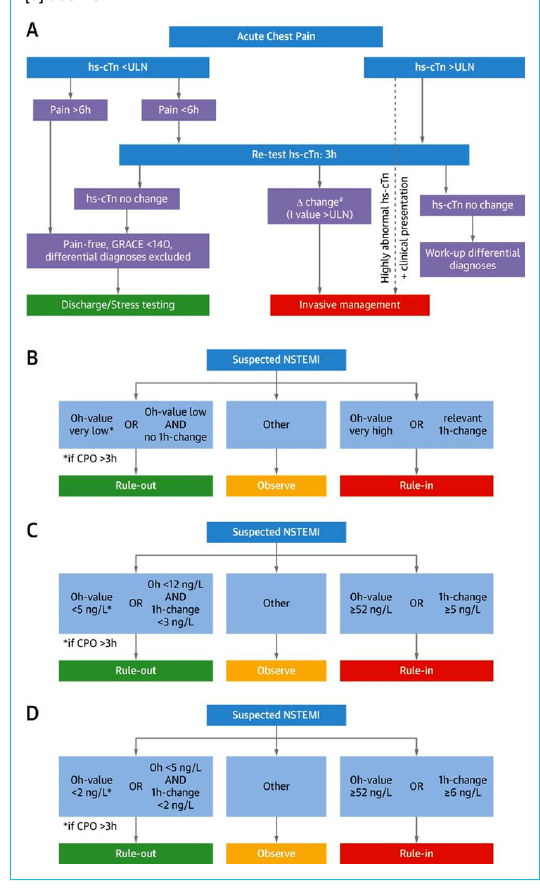
Figure 2: European Society of Cardiology (ESC) rapid triage algorithms. (A) The ESC 0/3h rule-out and rule-in algorithm of non–ST-segment–elevation myocardial infarction (NSTEMI) using high-sensitivity cardiac troponin (hs-cTn) assays. (B) The ESC 0/ 1h rule-out and rule-in algorithm using hs-cTn assays in patients presenting with suspected (NSTEMI) to the emergency depart- ment. (C) The ESC 0/1h rule-out and rule-in algorithm with assay- specific cutoff values for the Elecsys ® hs-cTnT assay by Roche.CPO = chest pain onsetAdapted from Twerenbold et al. [4] with permission from the publisher. Twerenbold R, Boeddinghaus J, Nestelberger T, Wildi K, Rubini Gimenez M, Badertscher P, et al. Clinical Use of High-Sensitivity Cardiac Troponin in Patients With Suspected Myocardial Infarction. J Am Coll Cardiol. 2017;70